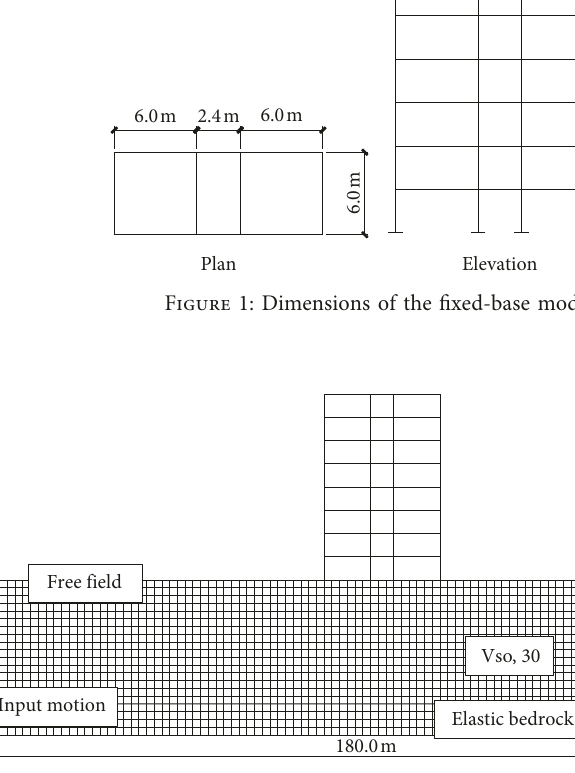
Figure 2: Dimensions of the SSI model.